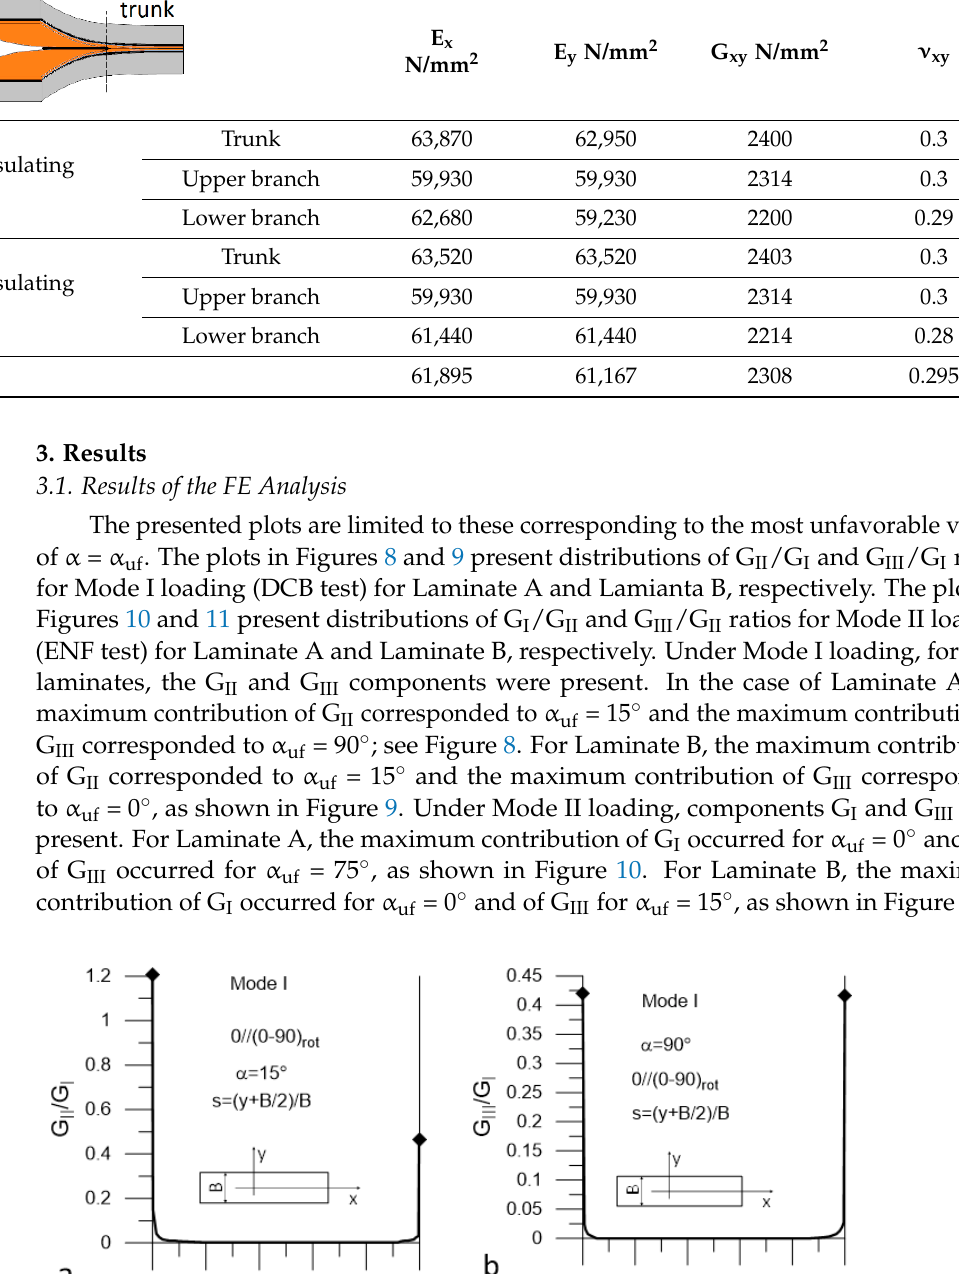
Figure 8. Mode I loading; ( a ) G II /G I (s) ratio and ( b ) G III /G I ratio for Laminate A.